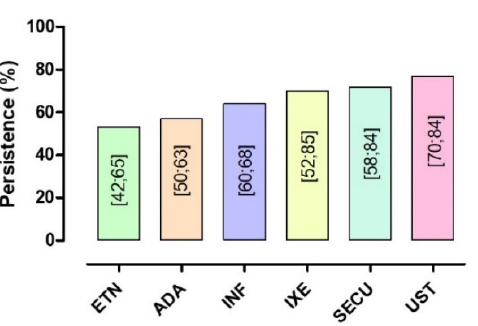
Figure 6. Forest plot of proportions, and their 95% confidence intervals, of persistent patients strat- ified according to biological drugs.